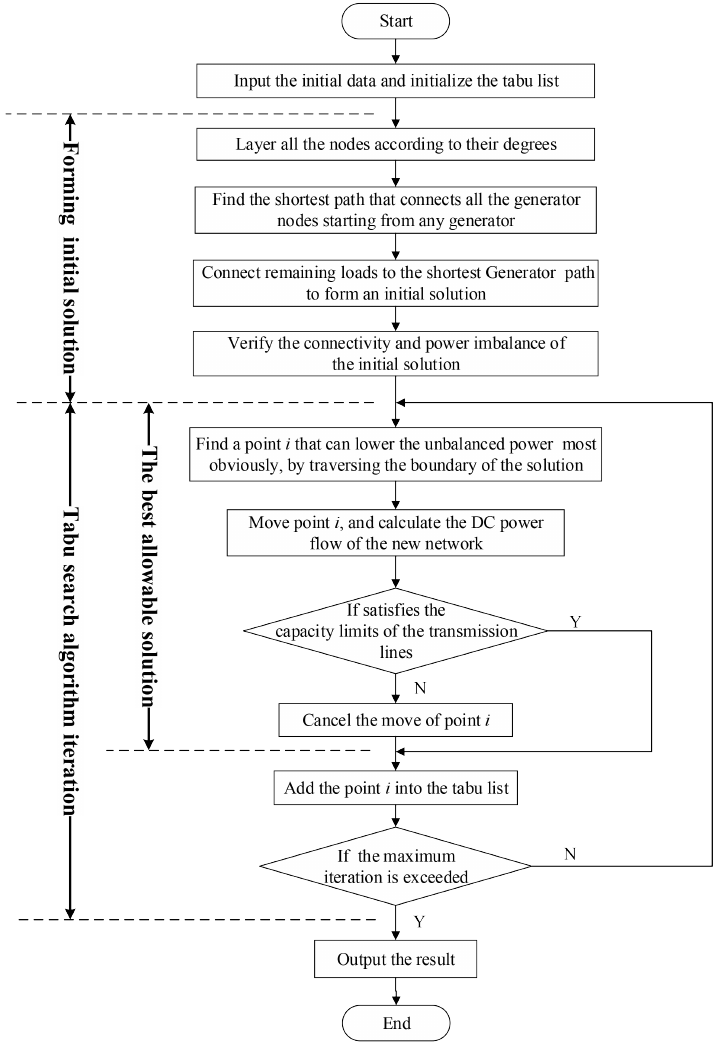
Figure 9. The procedure of the islanding